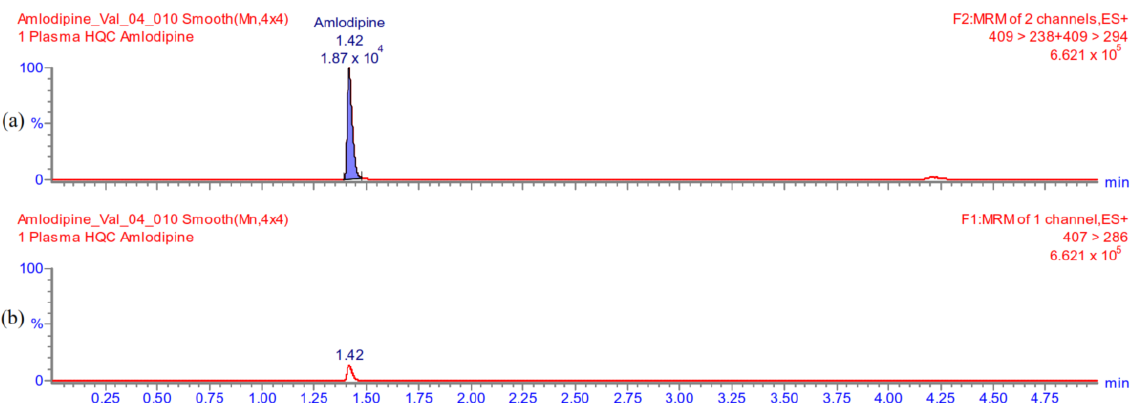
Figure A3. MRM chromatograms of human blood plasma samples spiked with AML at 40.0 ng/mL. ( a ) AML MRM chromatogram. ( b ) DAML MRM chromatogram (bottom plot).